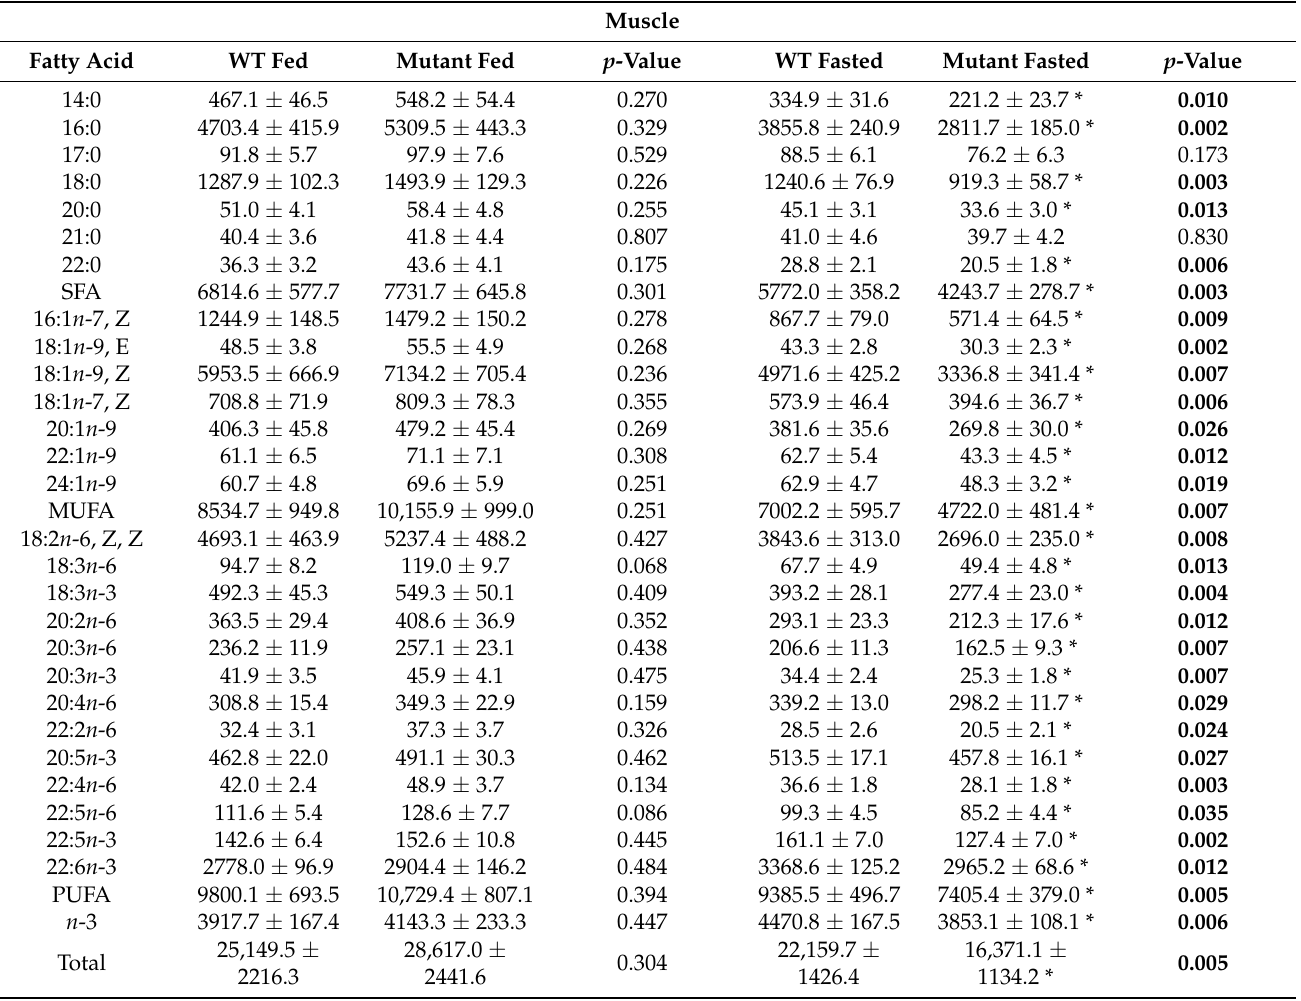
Table 2. Fatty acid content ( µ g/g tissue) of muscle tissue from WT and LepR mutant rainbow trout that were fed to satiation or fasted for six weeks. Data shown is from the final sampling at six weeks, and values are reported as means ± SEM. * and bold values denote a significant difference between WT and mutant fish groups ( n = 15).